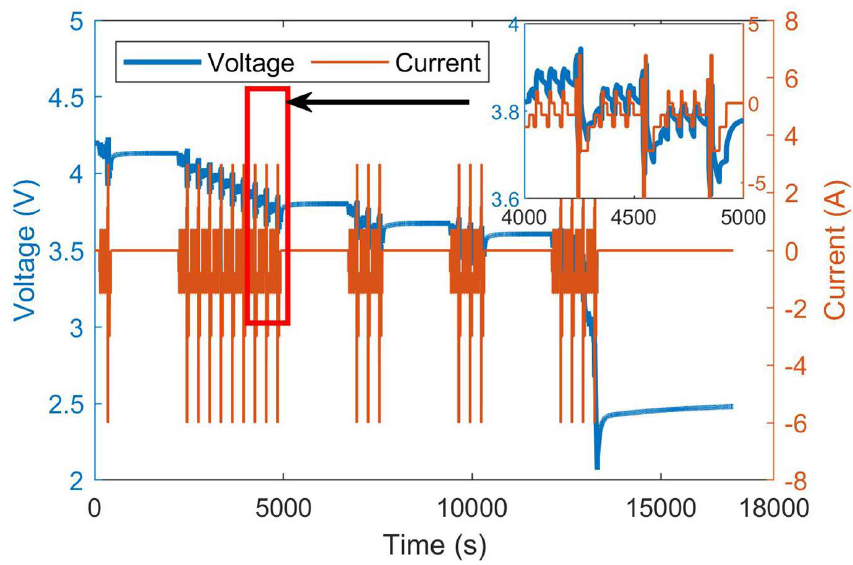
Figure 3. Current and voltage of the DST